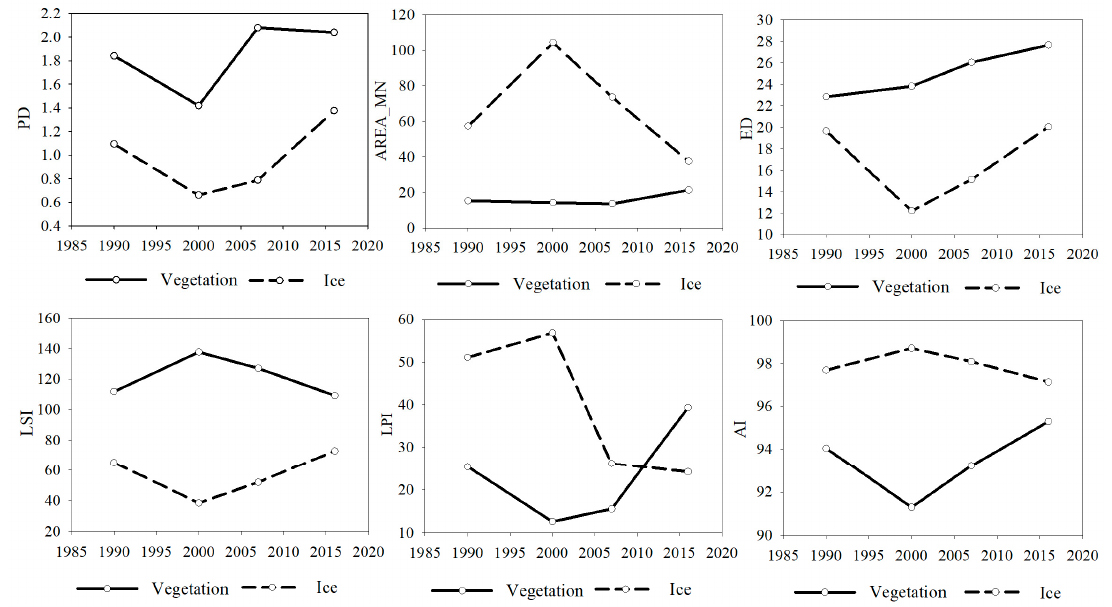
Figure 4. Changes in the class-level landscape indexes (PD, AREA_MN, ED, LSI, LPI, and AI) from 1990-2016.